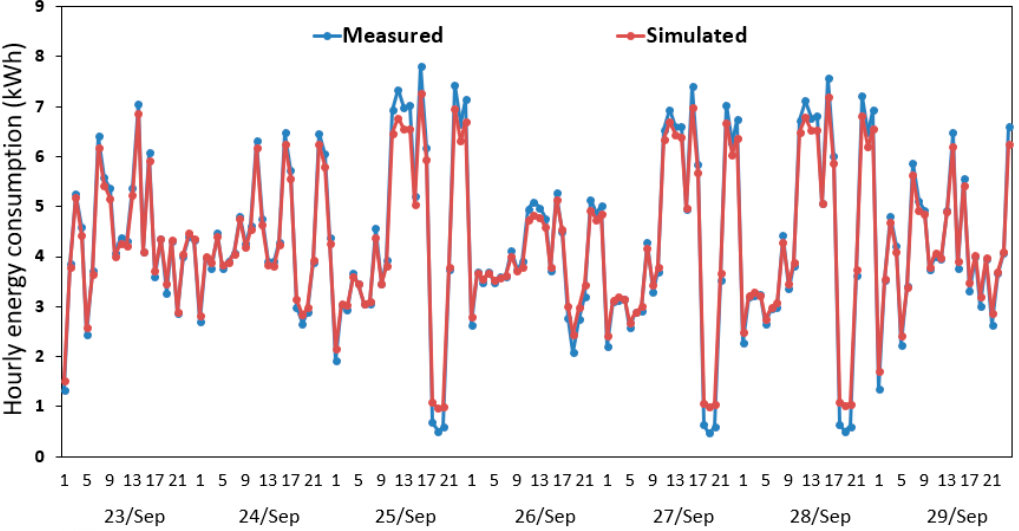
Figure 5. Calibration of simulation model with measurements conducted in the AC3 zone of the target house in Kuwait.